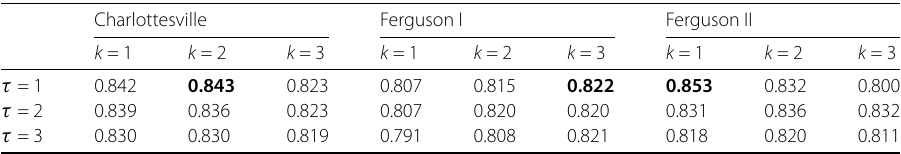
Table 3 AUC results of ActAttn with respect to different window size k and lead time τ Charlottesville Ferguson